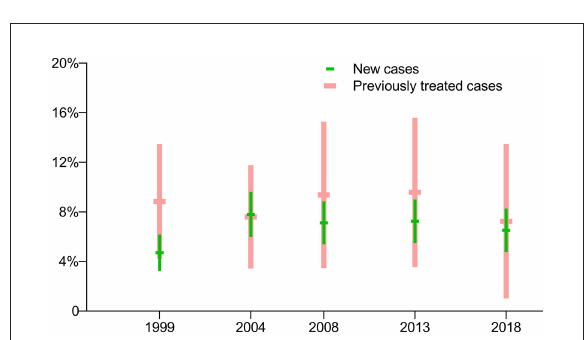
FIGURE2 Prevalence of isoniazid-resistant TB: breakdown by treatment history in five periodic surveys.